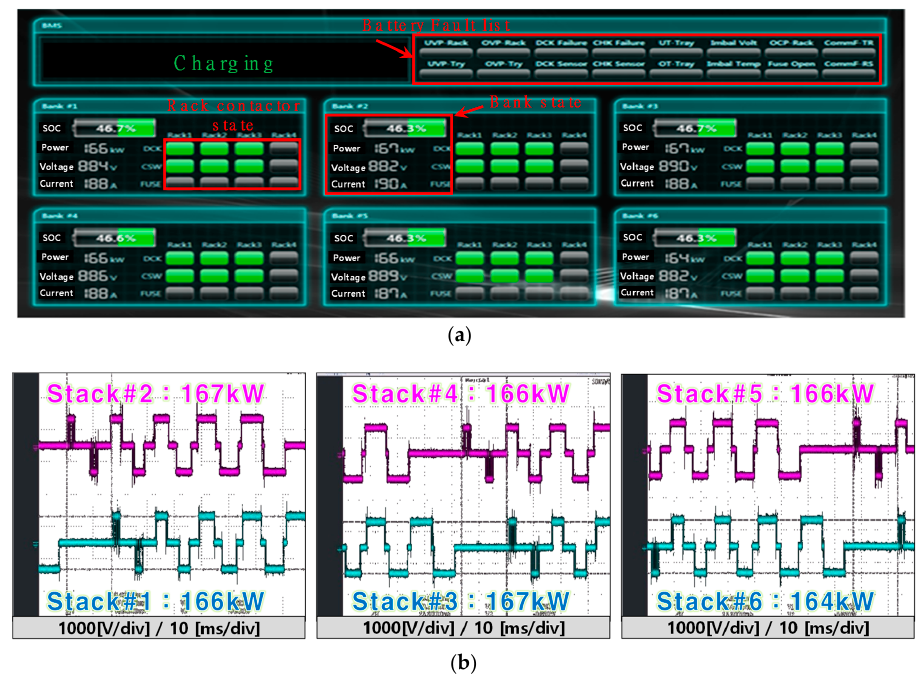
Figure 20. Results of battery balancing according to RPR mode: ( a ) Battery condition for each bank measured on the PMS and ( b ) output waveform of each cell inverter measured by the oscilloscope.